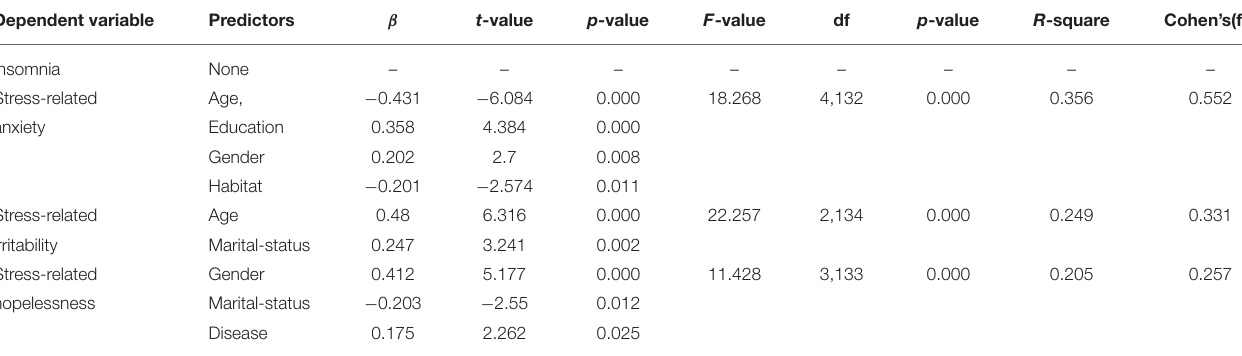
TABLE 5 | Results of stepwise linear regressions with the demographic variables.